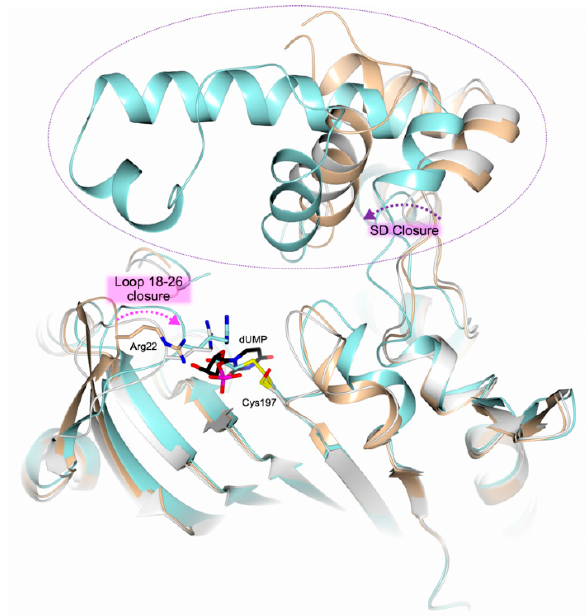
Figure 4. Structural comparison of the different states observed in the structure of substrate-free Ef TS (PDB id 3UWL [5], open conformation in gold and closed conformation in light blue) and in its complex with dUMP (open conformation in white, only the dUMP-bound subunit is shown). The closed conformation of both SD (circled) and loop 18–26 is observed in subunits B and D of substrate-free Ef TS (light blue cartoon and carbon atoms) where 5-FTHF is bound. The open conformation of SD and loop 18-26 is observed in chains A and C of the substrate-free enzyme (gold cartoon and carbons). In the Ef TS–dUMP complex (in white), a closed conformation of loop 18–26 is visible in the dUMP-bound subunits. In Ef TS, the open/closed transition occurs as a biphasic process in which the dUMP binding triggers the closure of loop 18–26 (pink dashed arrow), whereas the binding of the cofactor (or analogue) induces the movement and the organization of the whole SD (purple dashed arrow).